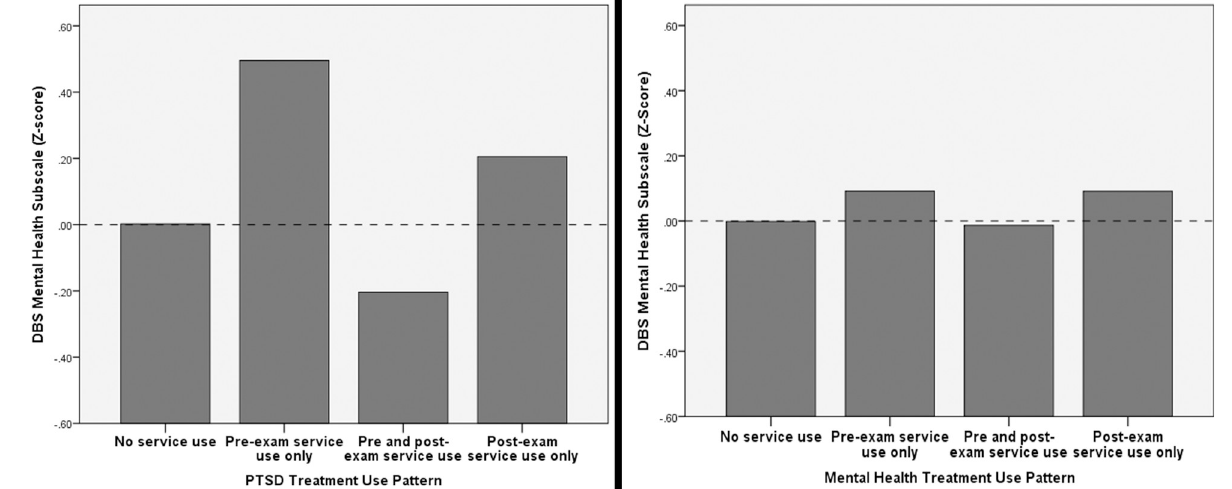
Fig 1. PTSD service use and mental health service use patterns by DBS mental health subscale score.